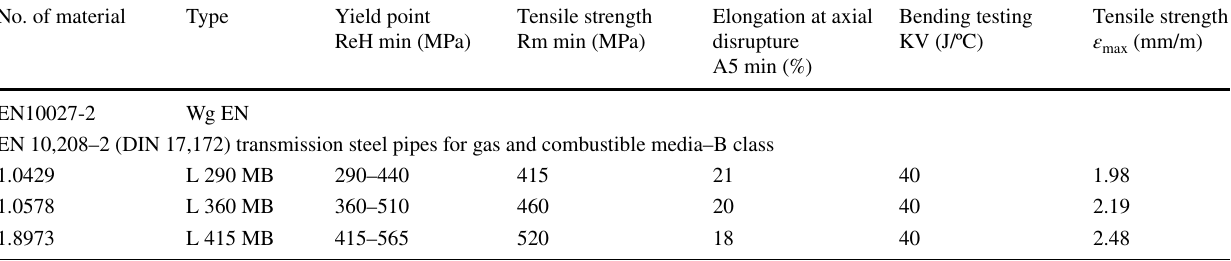
from blue color to pink according to the date when the mining was planed, some blue mining panels was done already, dates of mining planed are signed on the map